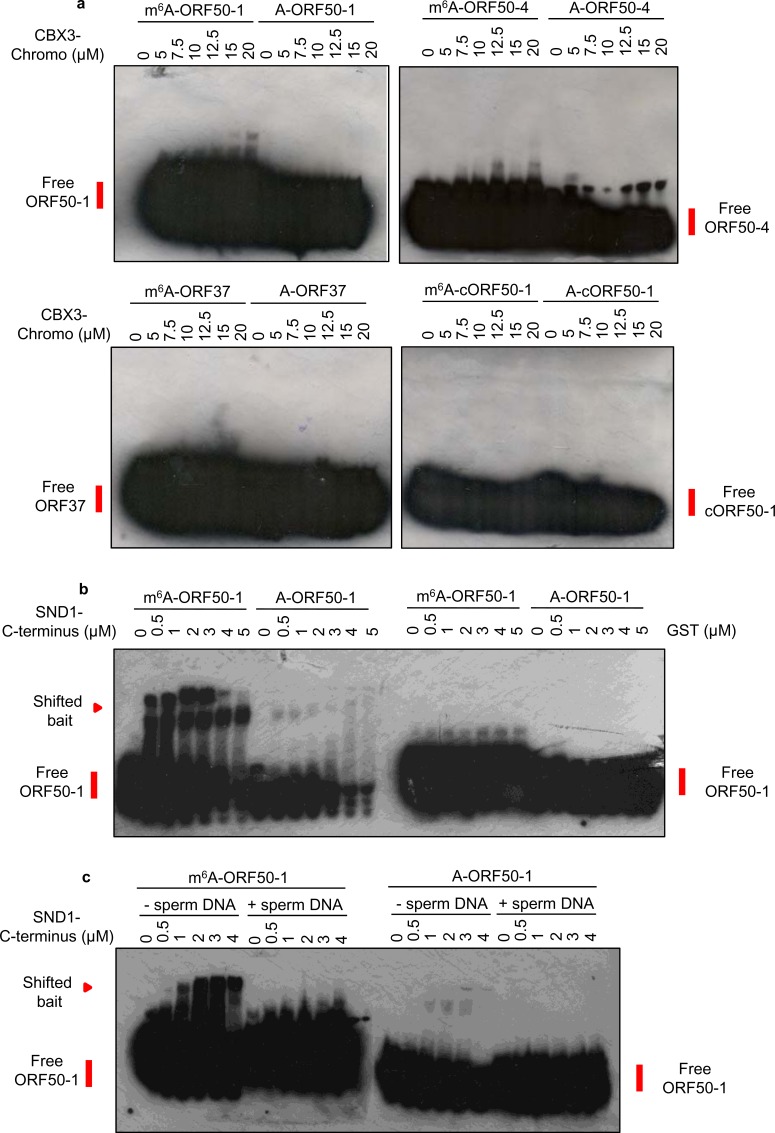
Neither CBX3 chromodomain nor GST protein show selectively for binding m6A-modified RNA.(a) EMSAs were carried out using recombinant GST-CBX3-Chromo domain (residues 29–86) and biotinylated viral RNA baits. cORF50-1, cropped ORF50-1. Representative EMSAs from two different protein preparations are shown. (b) EMSAs were carried out side by side using recombinant SND1-C-terminus protein (residues 548–910) and control GST protein. Up to 15 µM GST protein was also tested without showing any shift (data not shown). (c) EMSAs were carried out using recombinant SND1-C-terminus protein (residues 548–910) in the absence (-) or presence (+) of herring sperm DNA (5 µg per binding reaction). Representative EMSAs from two different protein preparations are shown.